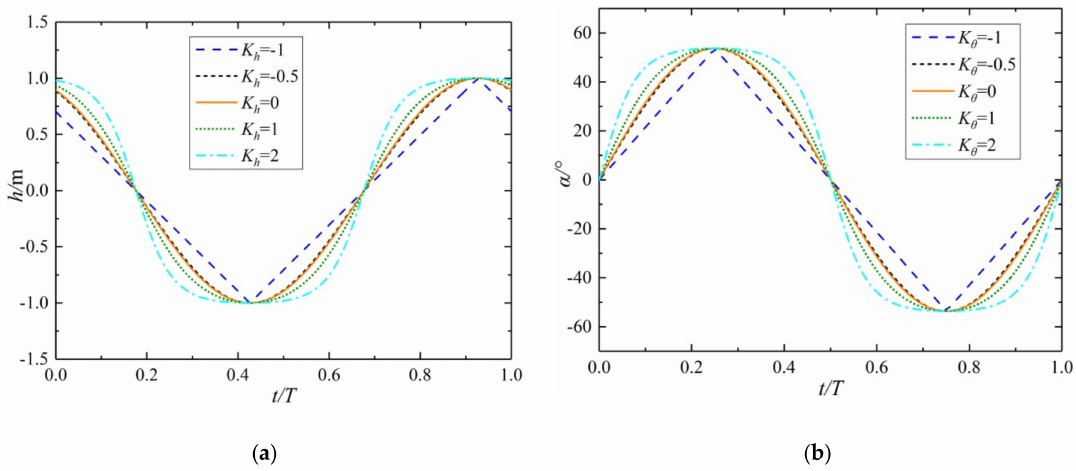
Figure 4. The curves under the different non-sinusoidal motions at k = 0.8: ( a ) non-sinusoidal plunging motion; ( b ) non-sinusoidal pitching